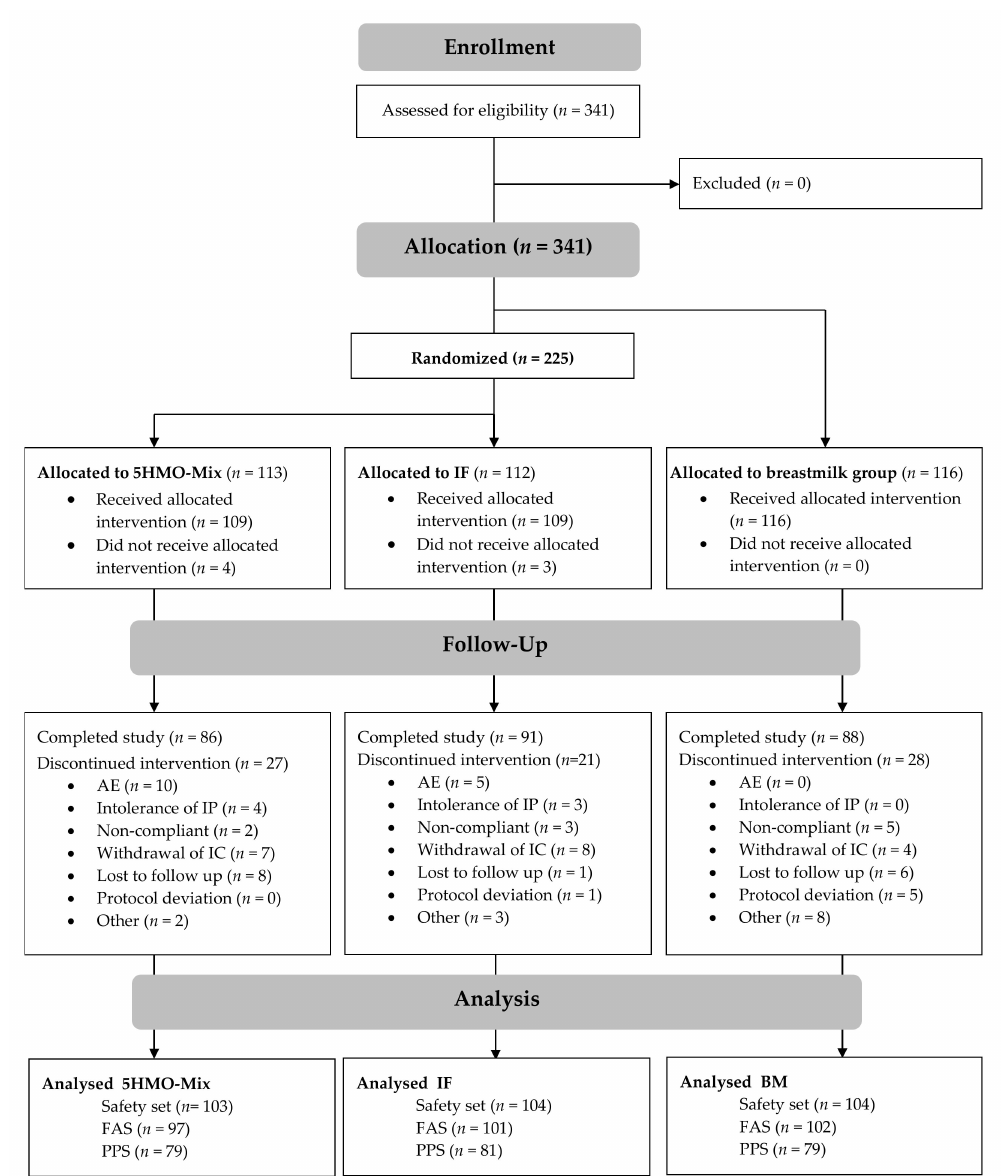
Figure 2. Consort diagram showing the disposition of subjects. No significant differences in weight-for-age z-scores were observed between the 5HMO-Mix and IF groups at any time point between V2 and V6 in the FAS. Compared to the BM group, the mean z-scores were slightly higher in both intervention groups at V6. For the remaining time points, there were no significant differences between either of the intervention groups and the BM group. The length-for-age z-score in the FAS differed between the IF and BM groups at V2 (the value was slightly higher in the IF group), but no significant differences were observed in the PPS. No significant differences in length-for-age scores were observed between the two intervention groups in the FAS at any of the time points between V2 and V6. Compared to the BM group, the mean z-scores were slightly higher in the intervention groups at both V5 and V6. There were no significant